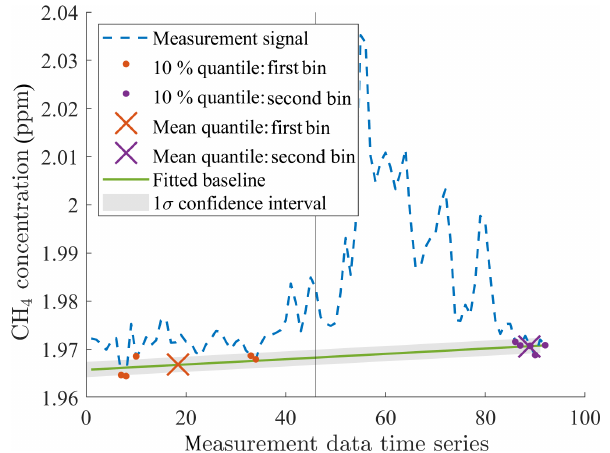
Figure 5. Baseline determination by dividing the measurement signal (blue) into two halves. Afterwards, a line (green) is fitted through the mean values of the lowest 10% of concentration points of each half. The grey shaded area denotes the 1 σ uncertainty range of the